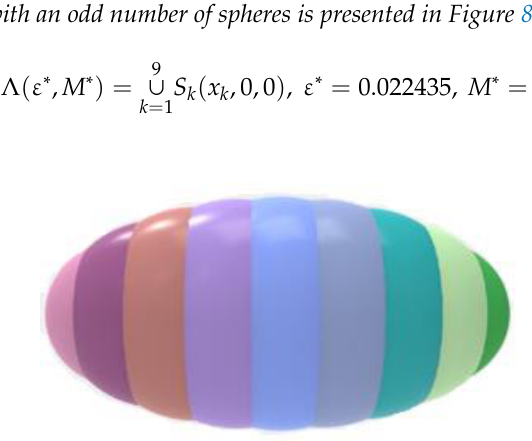
Figure 7. The optimized cover of the spheroid E : ( a ) by M ∗ = 4 spheres; ( b ) by M ∗ = 5 spheres. Instance 4. The spheroid E with semi-axes a = 2, b = c = 1 is given and ε = 0.03.